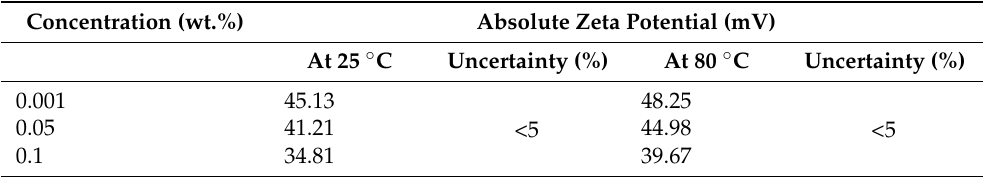
Table 5. Zeta potential values of TH-55/DP nanofluids. Concentration